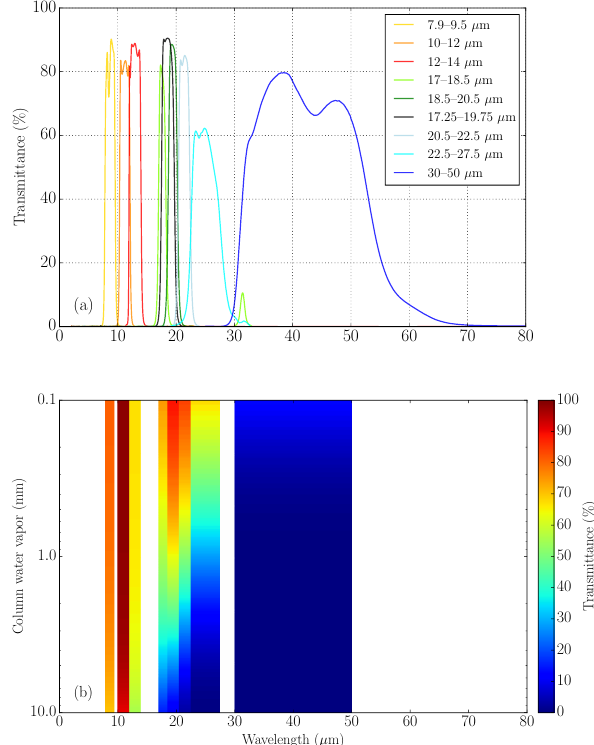
Figure 2. (a) Spectral transmittance of the nine filters of the FIRR. (b) Atmospheric transmittance of the standard subarctic winter at- mosphere in the bands of the FIRR as a function of column water vapor, as calculated with MODTRAN. For the sake of clarity, the band 17.25–19.75µm is not shown because it overlaps with other